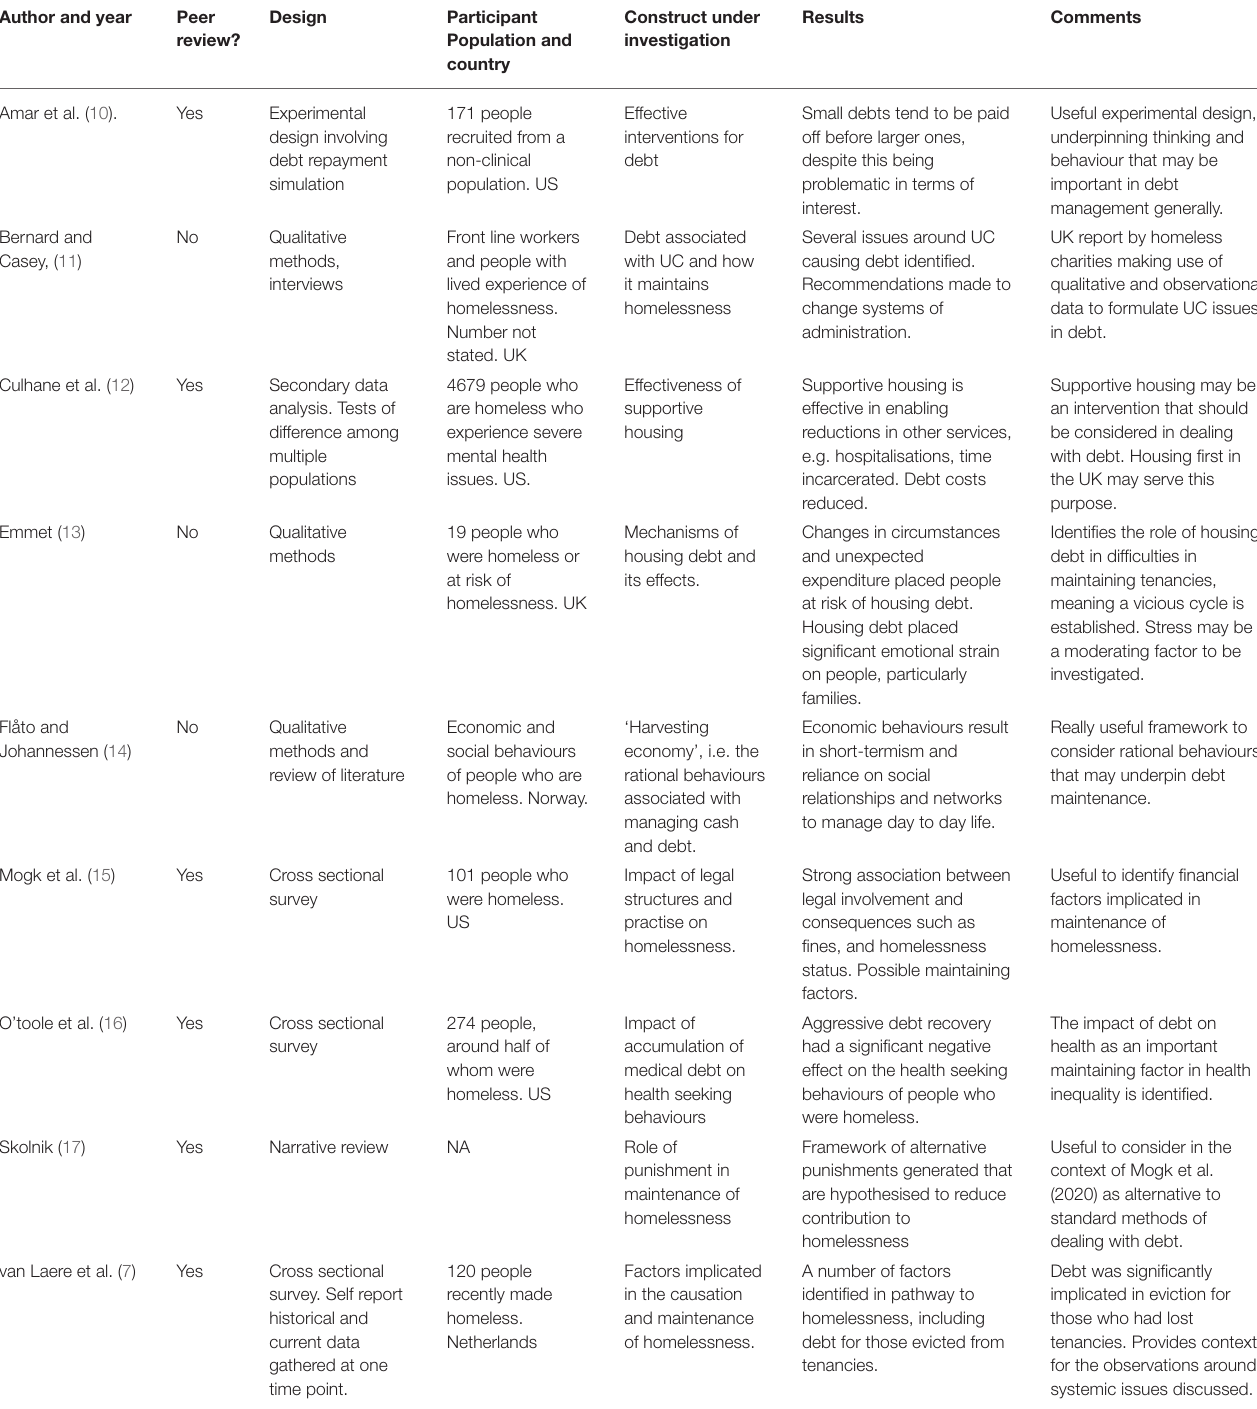
TABLE 1 | Papers on homelessness and debt identified through literature